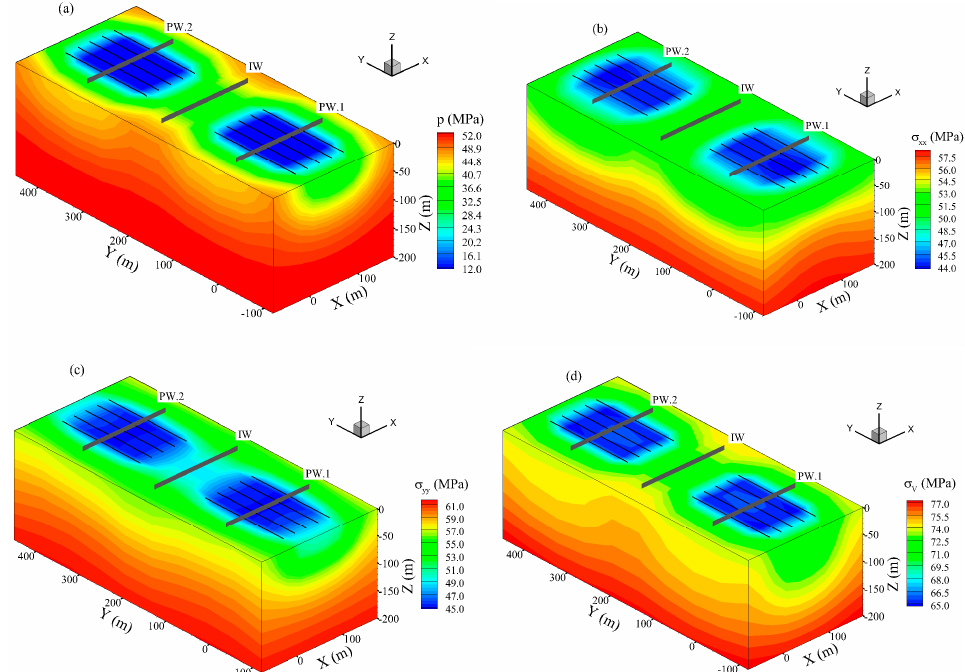
Figure 12. A 3D visualization of the reservoir pore pressure and total stress changes around “Production” and “Infill” wells after 2 years of production, ( a ) reservoir pore pressure, ( b ) horizontal stress component σ xx , ( c ) horizontal stress component yy , ( d ) the vertical stress zz . Reservoir pore pressure decreased in an expanding ellipsoidal shape around the production fracture, resulting in a decrease of all three total stress components. Insitu reservoir pore pressure and stresses at the wellbore level are equal to p 0 = 50.68 MPa, σ V = 73.12 MPa, σ H = 57.72 MPa, σ h = 54.3 MPa.